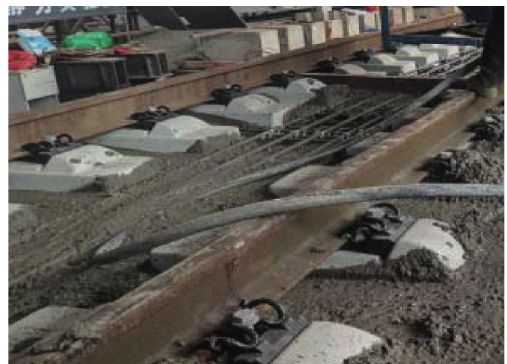
Figure 5: Unballasted tracks cast in place.